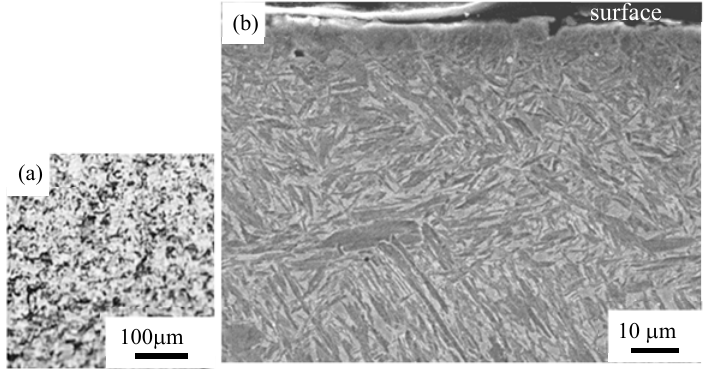
Figure 4. Variations in ( a ) maximum volume fraction of the retained austenite ( f γ ,max ), ( b ) maximum hardness (HV max ), and ( c ) maximum compressive residual stress ( σ X α ,max ) as a function of carbon potential ( C P ) in TM ( ○ ● , thick lines) and SNCM420 ( △▲ , thin lines) steels after vacuum ‐ carburization (VC) or after vacuum carburization and subsequent fine ‐ particle peening (VC + FPP). HV max,c is HV max of as ‐ vacuum ‐ carburized steels.